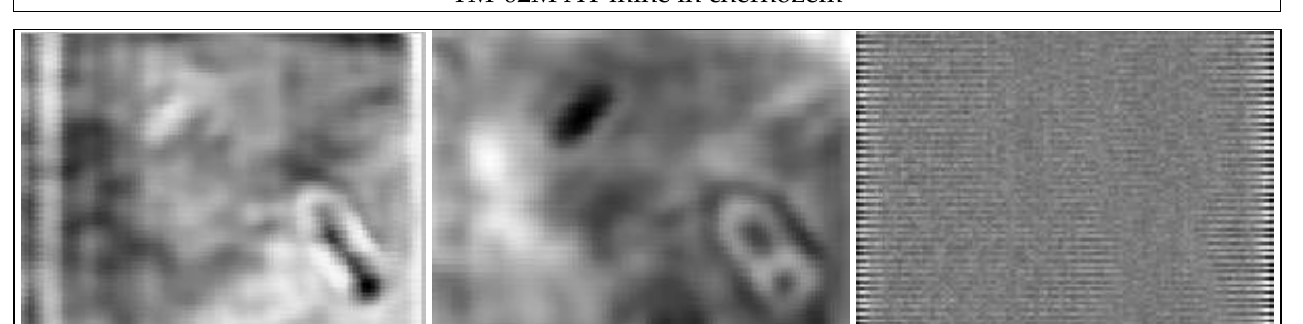
Figure 16. HSR and MD images of mines and clutter.